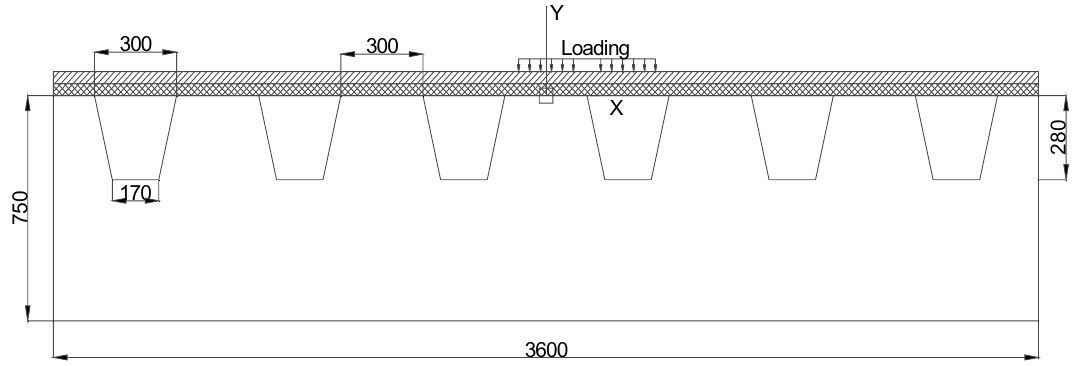
Figure 1. The section of OSD pavement structure (Unit: mm, not to